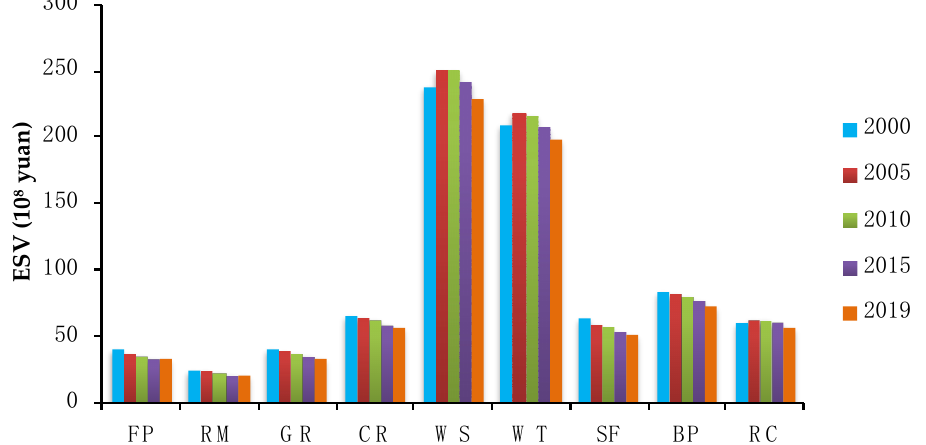
Figure 4. Changes in ESV under the secondary classification of SCBJ from 2000 to 2019. Note: Acronyms are defined as Food production (FP), Raw material production (RM), Gas regulation (GR), Climate regulation (CR), Water supply (WS), Waste treatment (WT), Soil formation and protection (SF), Biodiversity protection (BP), and Recreation and culture (RC).